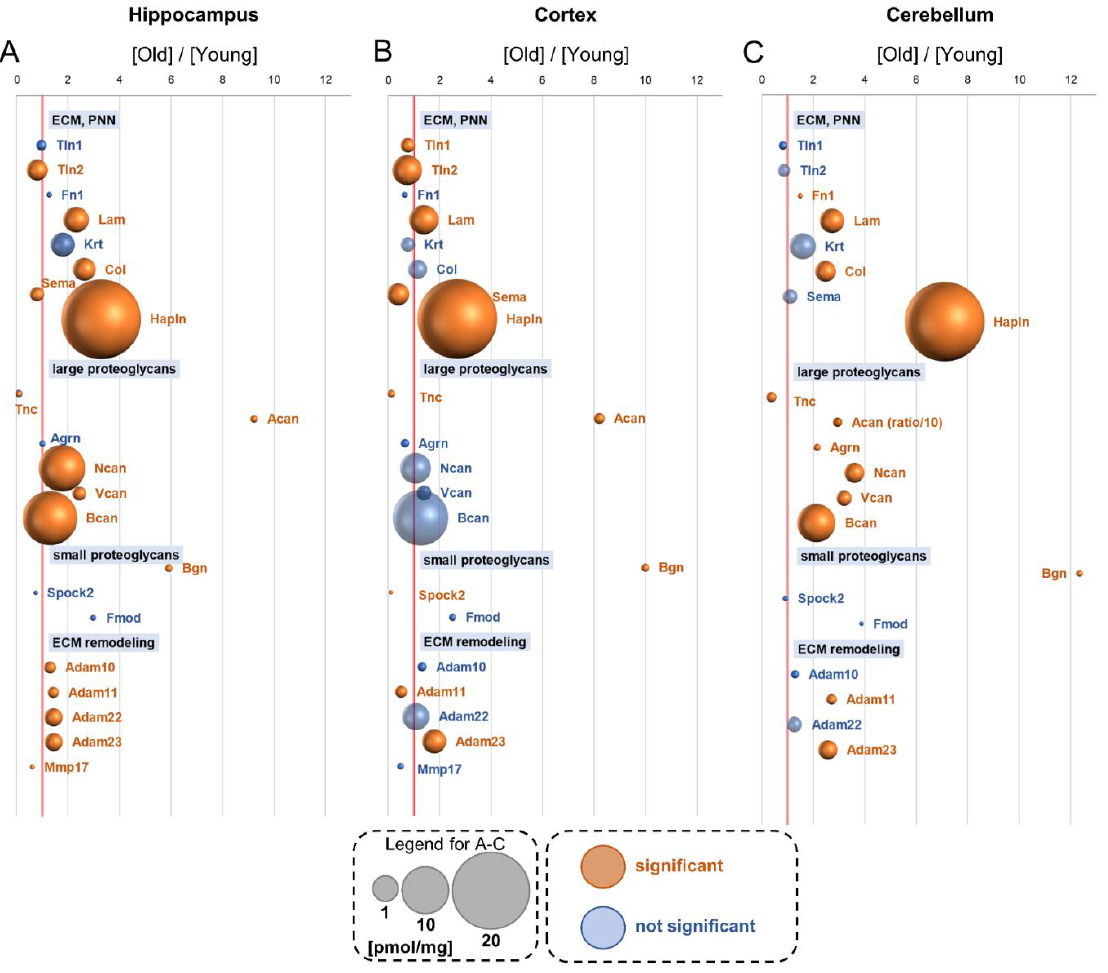
Figure 9. Changes in proteins of the extracellular matrix and perineuronal net group upon aging. Plot shows the ratios of the proteins in old vs. young brain formations in: hippocampus ( A ), cortex ( B ) and cerebellum ( C ). The size of bubbles is proportional to the average protein concentration in the respective old brain structures. Statistically significant differences are shown as the red